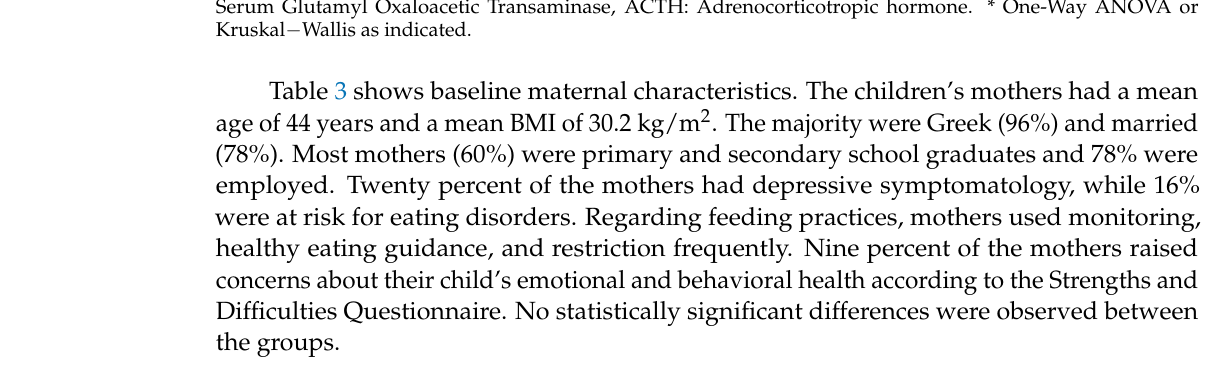
Table 3. Baseline parental (maternal) characteristics according to their children’s BMI z-score